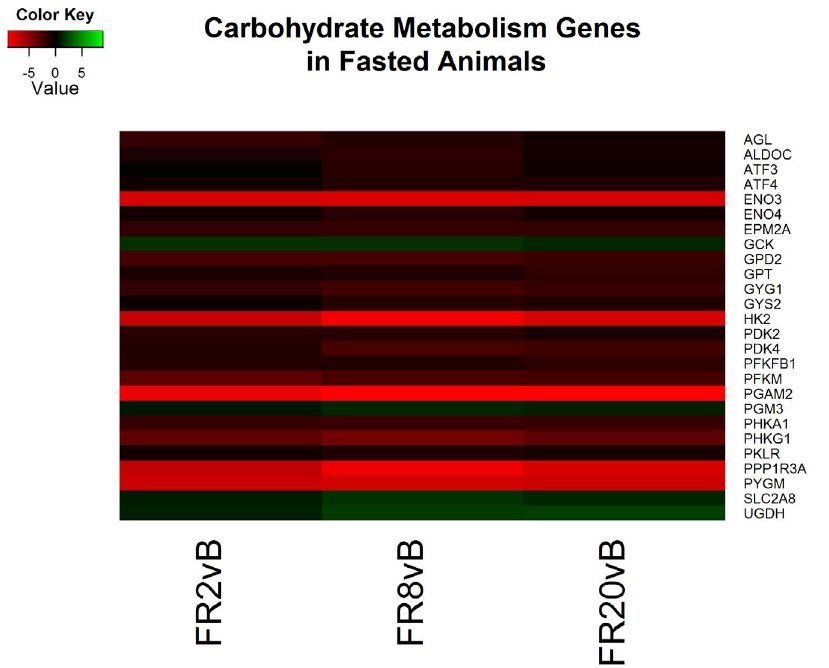
Figure 8. Heatmap of log2 fold changes of genes associated with carbohydrate metabolism in fasted (FS) animals at each resuscitation timepoint (2, 8, and 20 hours) relative to Baseline (B). Rows are differentially expressed genes (DEGs) following RNA sequencing. Columns denote the respective timepoints Baseline (B), 2 hours full resuscitation change from Baseline (FR2vB), 8 hours full resuscitation change from Baseline (FR8vB), and 20 hours full resuscitation change from Baseline (FR20vB). Green denotes increased mRNA expression with respect to Baseline whereas red denotes the opposite.